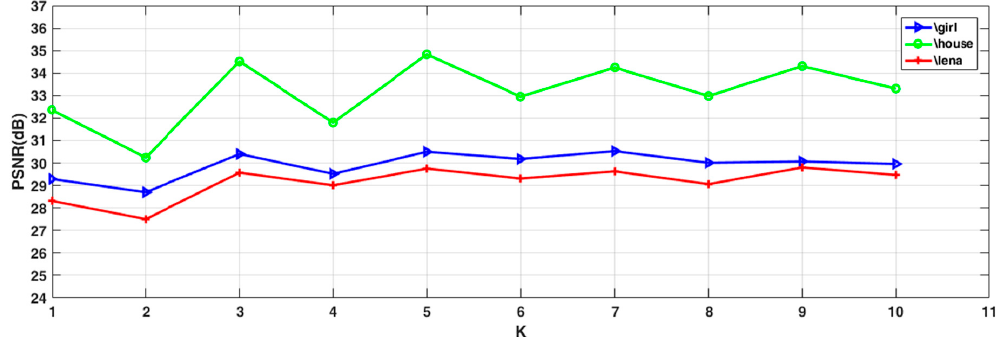
Figure 4. Comparison of peak signal-to-noise ratio (PSNR) under different K values (Noise Level = 30%). The test images (“Girl”, “House”, ”Lena”) are corrupted by 30% impulse noise.